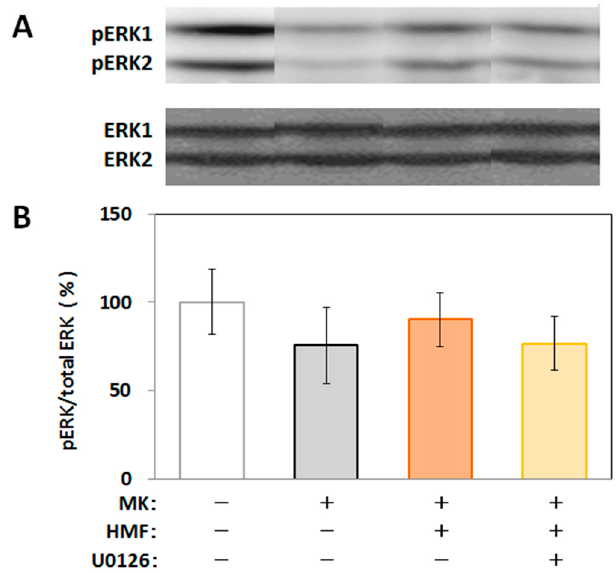
Figure 8. Western blot analysis of phosphorylation of ERK (pERK)1/2 in the U0126 and/or MK-801-treated mouse hippocampus. ( A ) Representative band patterns of pERKs and ERKs; ( B ) Quantitative analysis of the pERK/ERK ratios by use of Image J software. Values are the means ± SEM.